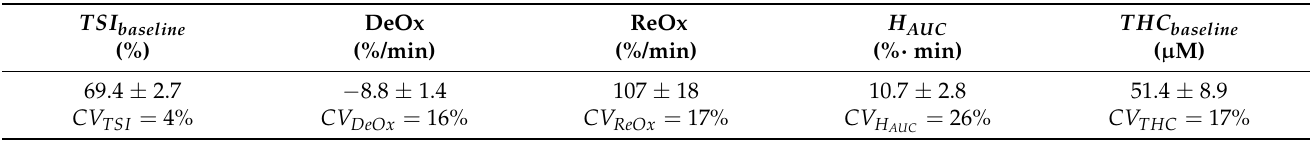
Figure 7. Parameters extracted from VOT over 20 repeated (once/day) measurements over 30 days. Horizontal lines represent the average (solid line) ± standard deviation (dashed lines) over all the measurements. See text for details. Table 5. Vascular occlusion test on a single healthy subject repeated once per day on 20 days over a month, indicating the average values and the variability. See text for